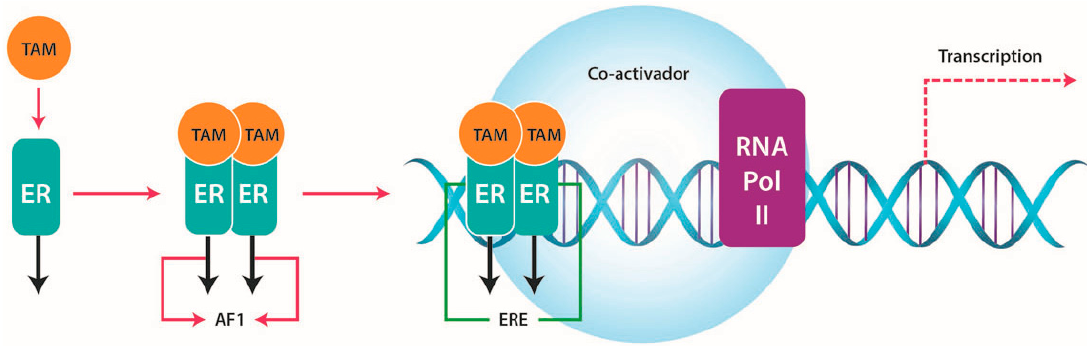
Figure 2. Tamoxifen action. The tamoxifen-estrogen receptor (TAM-ER) complex activates the activation factor 1 (AF1) domain and inhibits the activation factor 2 (AF2) domain. The TAM-ER dimer binds to DNA at estrogen response element (ERE) sequences in the promotor region of E2 responsive genes. Transcription of these genes is attenuated because the AF2 domain is inactive.